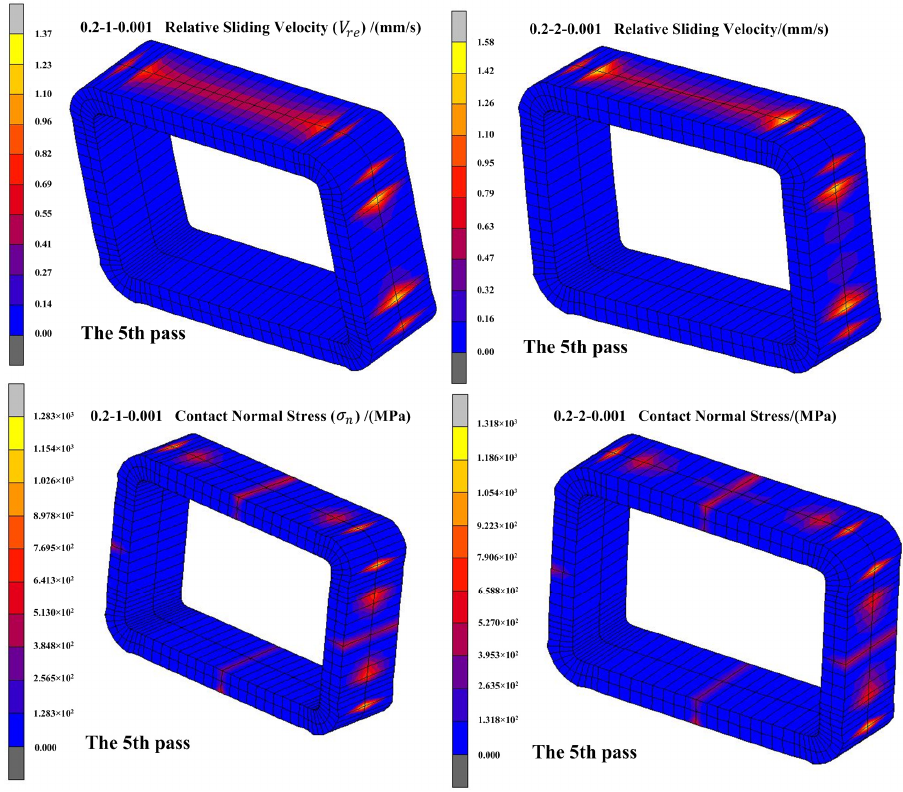
Figure 10. Simulation results of wear parameters under different flat roller angular velocity.